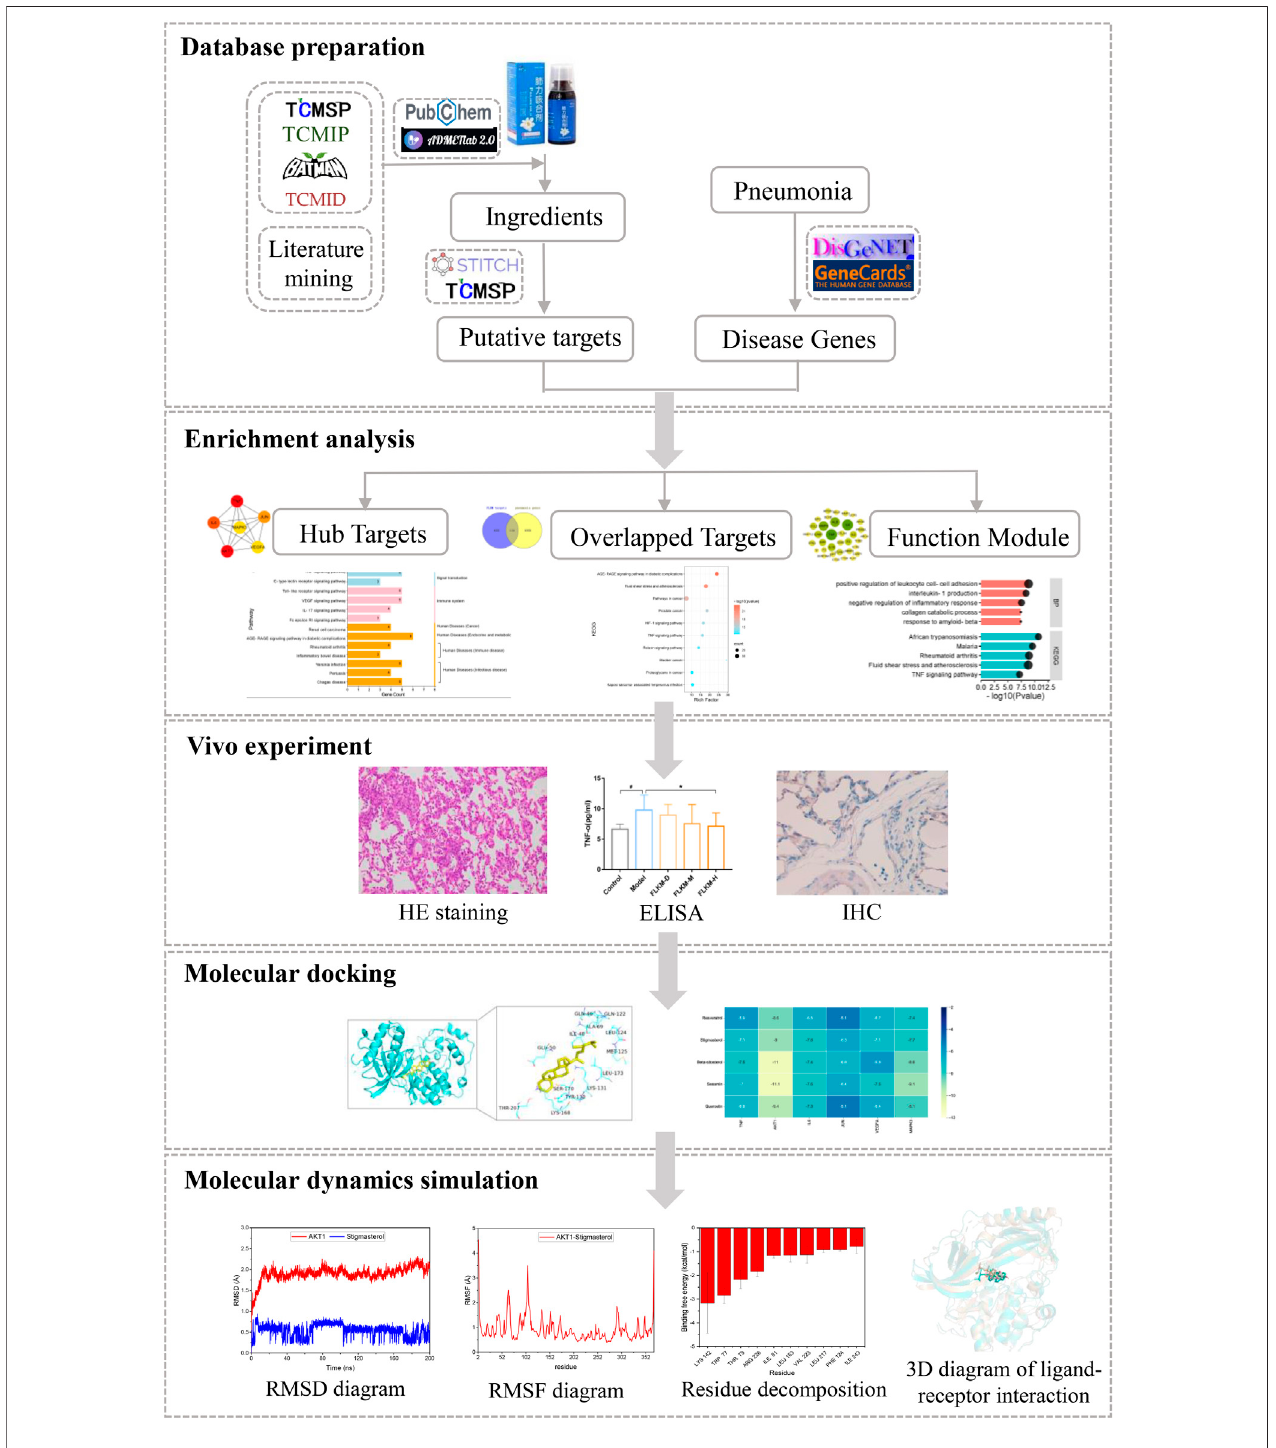
FIGURE 1 | The fl owchart of investigating the mechanisms of FLKM in the treatment of pneumonia.